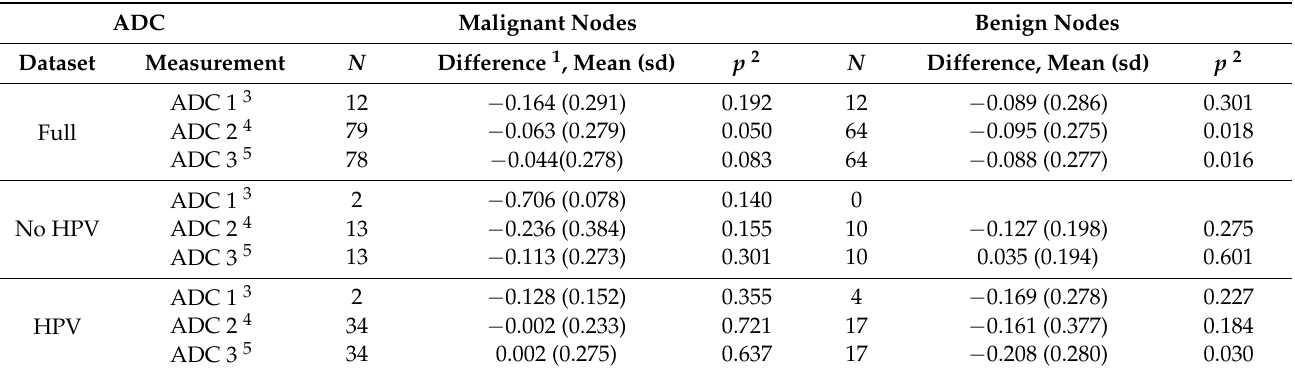
Table 4. Difference in minimum ADC values between the PET-negative reference node and PET- positive nodes.